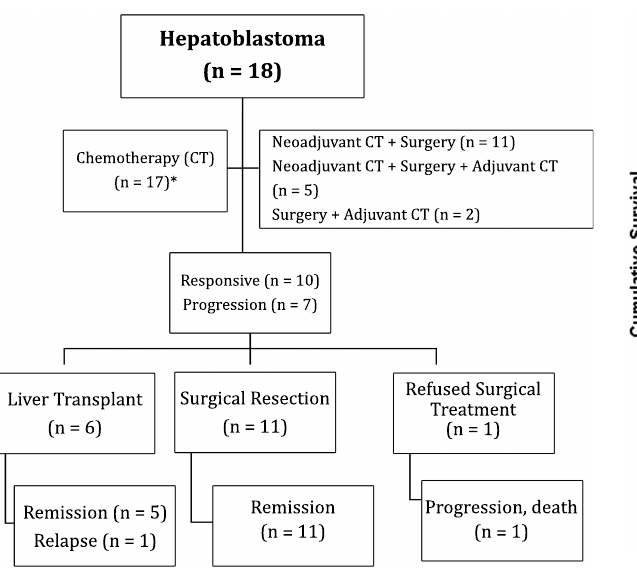
Figure 2. The 5-year overall rates and event-free rates.